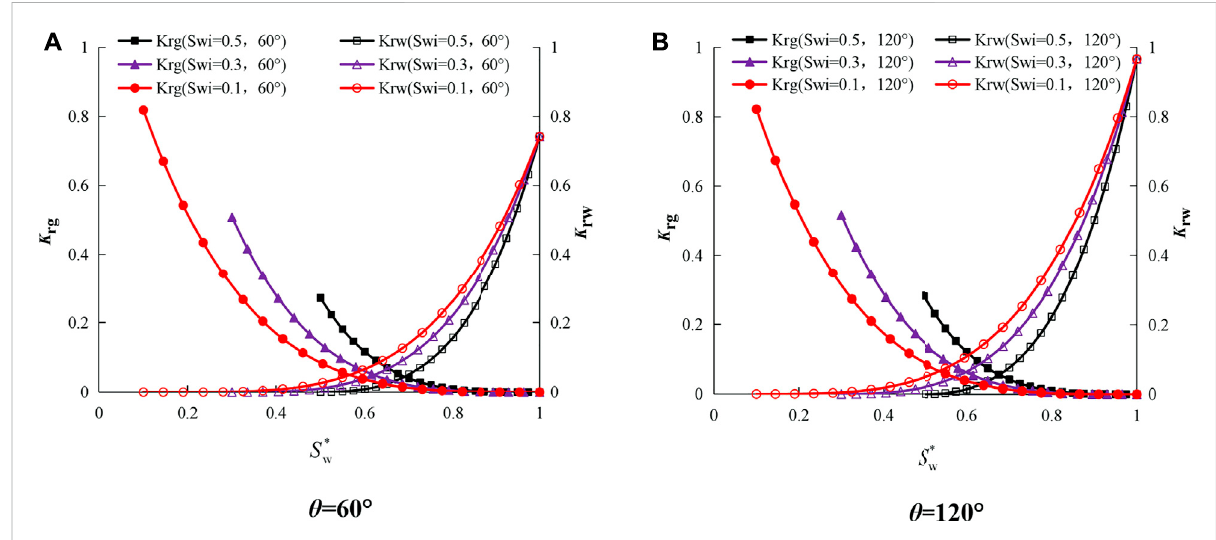
Effect of irreducible water saturation on the two-phase relative